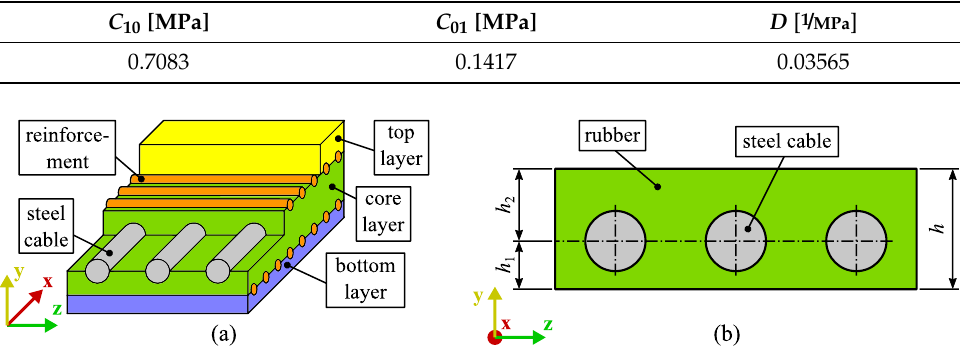
Figure 2. General structure of a conveyor belt with possible rubber layers and reinforcements ( a ) and cross-section of the conveyor belt used in this work ( b